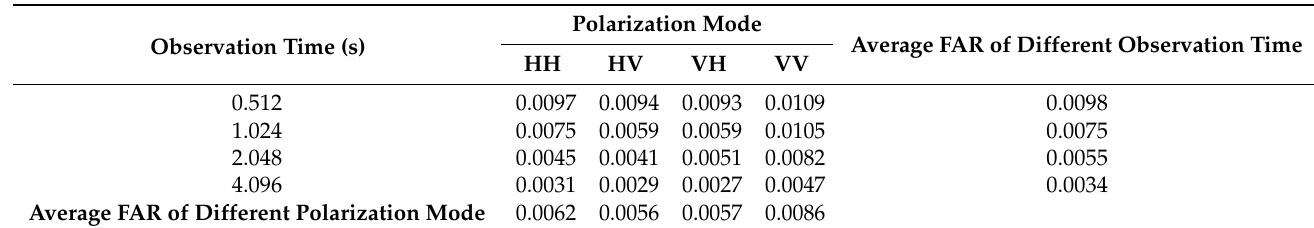
Table 9. Average FAR of different conditions.